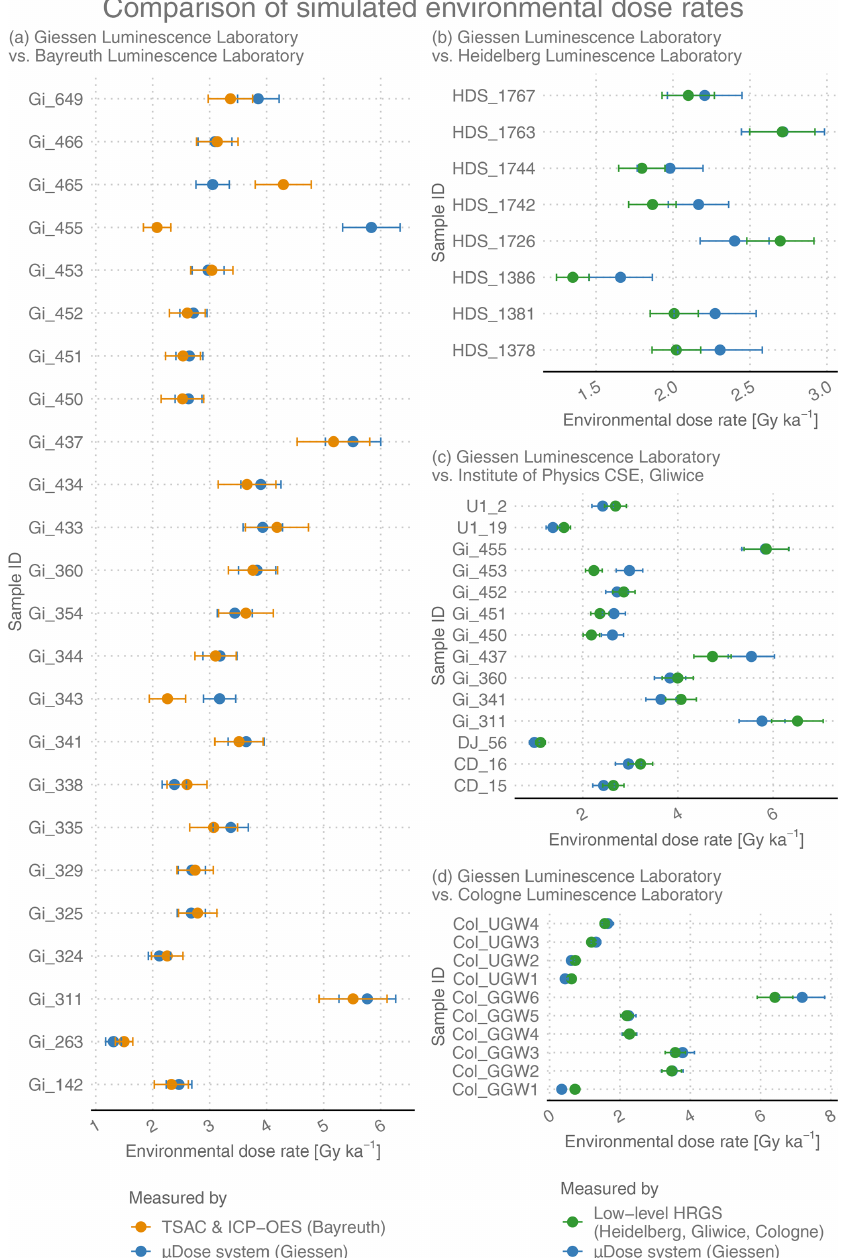
Figure 10. Comparison of simulated environmental dose rates for various natural samples. Assuming a constant water content of 15 ± 5% and a constant cosmic radiation of 0 . 150 ± 0 . 015Gyka − 1 , all values were calculated for the 90–200µm grain size fraction of HF-etched quartz using DRAC v1.2 (Durcan et al., 2015). Please be aware that these calculated values do not correspond to the actual dose rates and are thus referred to as “simulated environmental dose rates”. For details the reader is referred to the table notes of Table